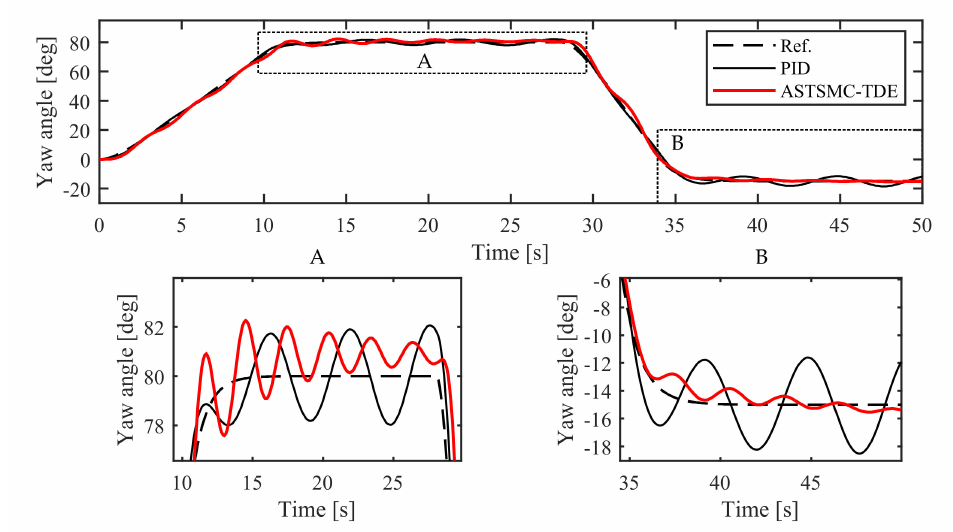
Figure 6. Simulation results of the yaw angle trajectory tracking in NM